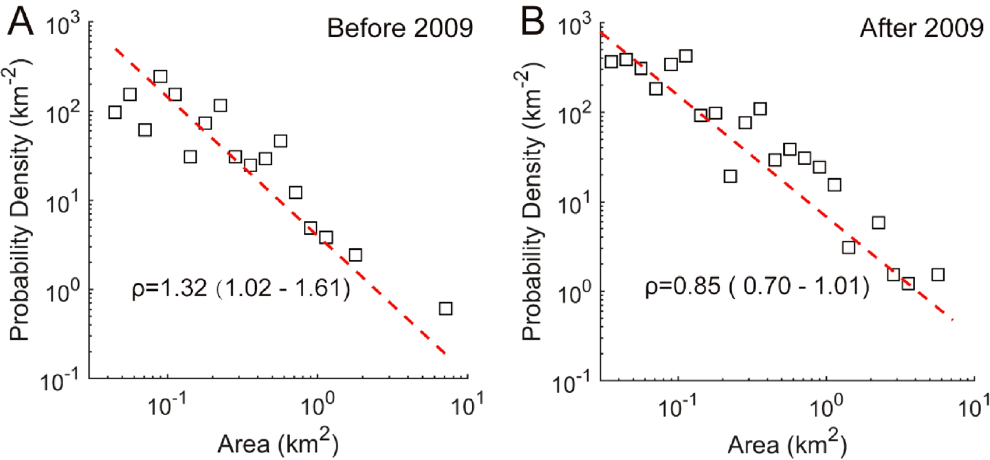
Figure 7. Comparison of frequency–area distribution for the 10 year period before 2009 and for 2009 and later. ( A ) is the frequency–area distribution for the 10 year period before 2009 with the decay factor ρ (1.32, 95%CI: